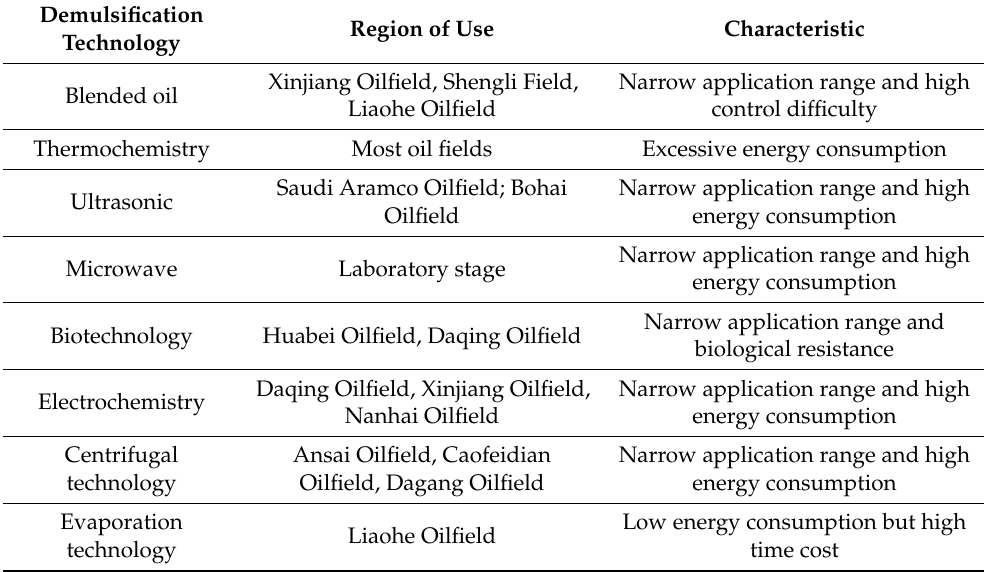
Table 1. Different demulsification technologies and their